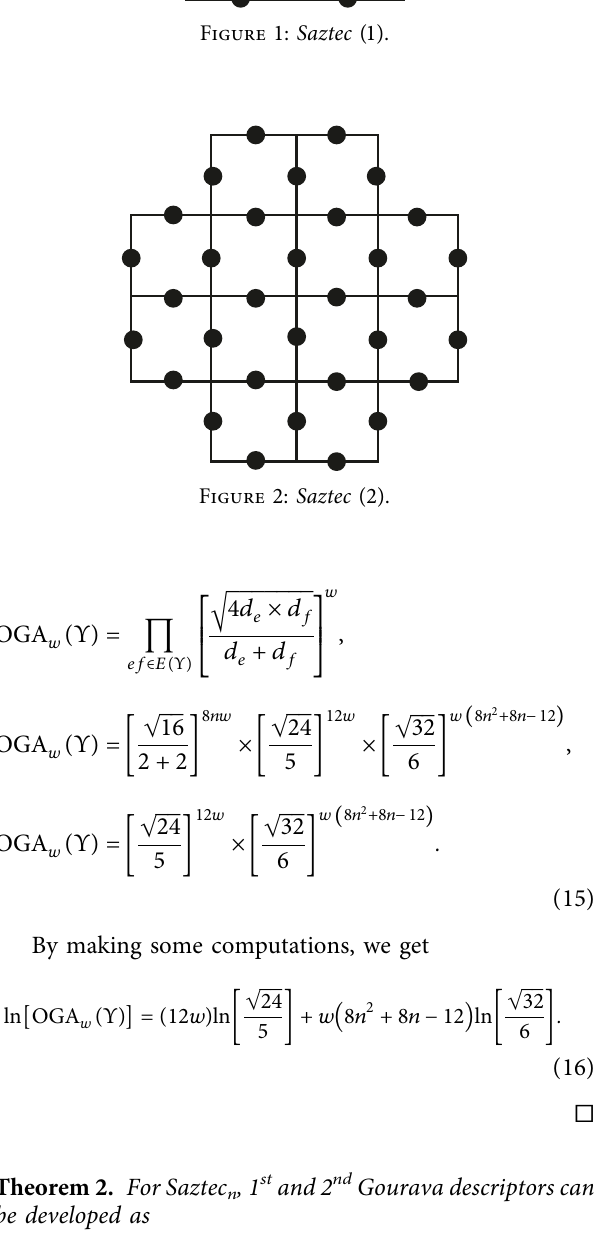
Figure 1: Saztec (1).